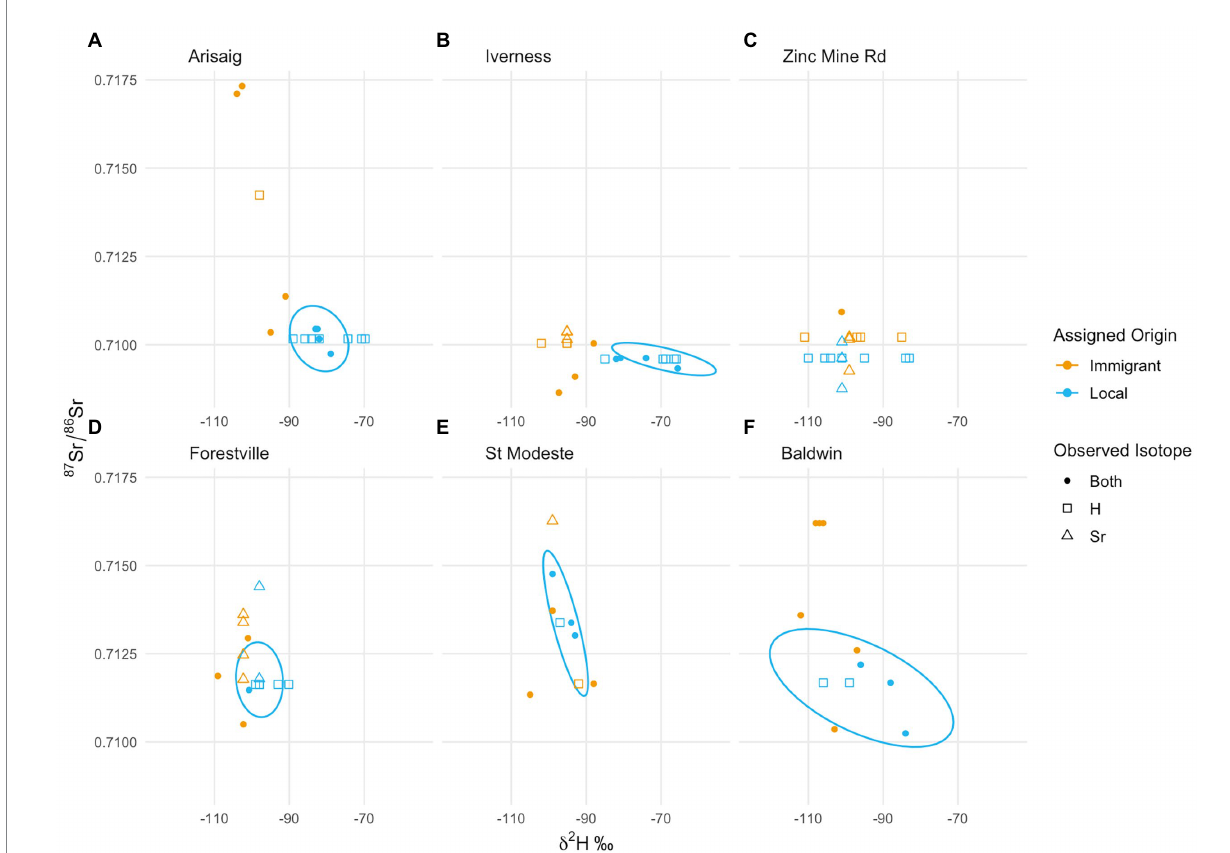
FIGURE 5 Dual isotope trait-space plot showing local population values (ellipse) and individual immigrants by site. Individuals with both a δ 2 H values and 87 Sr/ 86 Sr ratios are represented by filled symbols, individuals with only one isotope system measured are plotted at the median value of the isotope that was not measured. Points are segregated by putative immigrant/local status ( δ 2 H-only values = squares, 87 Sr/ 86 Sr-only ratios = triangles). Ellipses are bivariate normal, centered in the media value of both isotope systems and used to visually discriminate between the local signal and immigrants. Zinc Mine only had one individual with dual isotope data, and we could not parametrize an ellipse. Each panel (A–F) represents an independent sampling site/trap